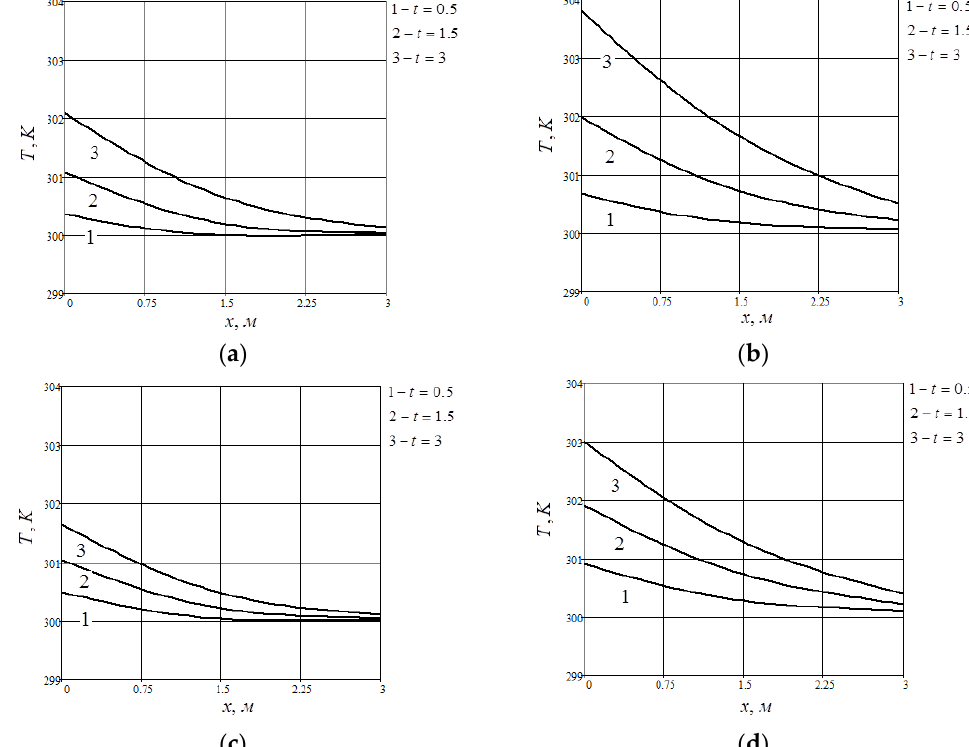
Figure 1. Graphs of temperature distribution in a semi-infinite body at different moments of time at: ( a ) α = 1, β = 2; ( b ) α = 1, β = 1.7; ( c ) α = 0.7, β = 2; ( d ) α = 0.7, β = 1.7. For all cases: q c = 1.8 W λ = 2.5 W , T 0 = 300 m · K